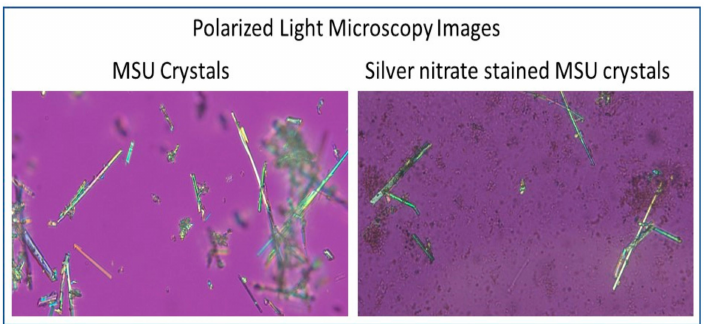
Figure 1. Urate crystals with and without silver nitrate stain under polarized light microscopy.